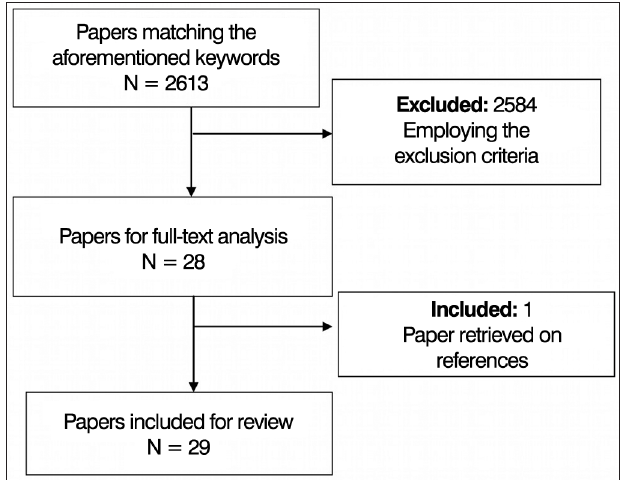
Figure 1. Diagram explaining the process of paper